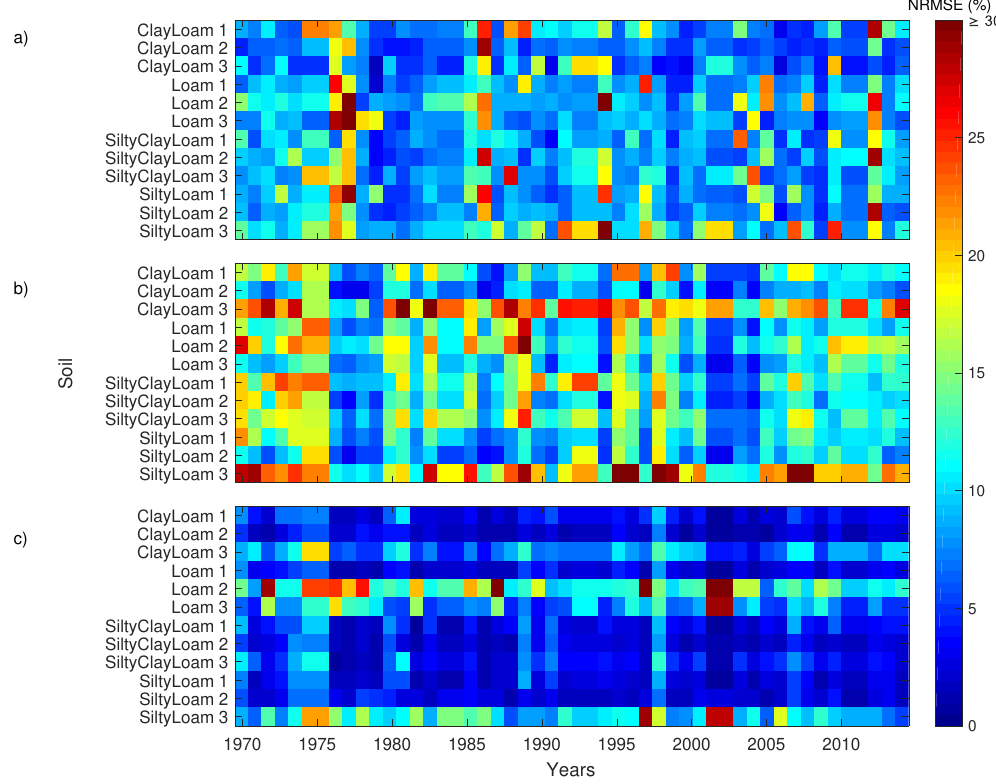
Figure 9. Normalised Root Mean Square Error (NRMSE) for maize ( a ), sugar beet ( b ), and wheat ( c ), for every soil type, from 1970 to 2014.